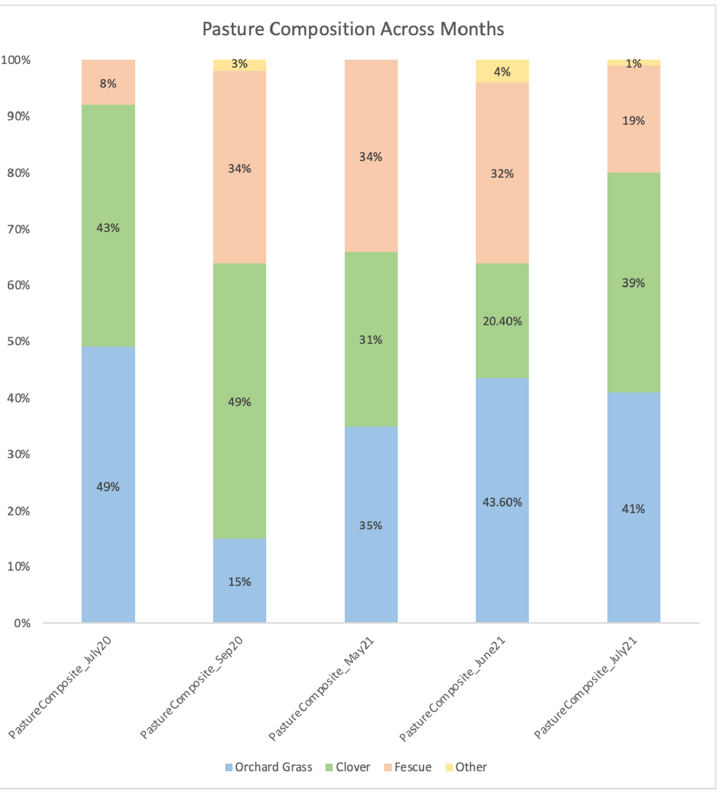
Figure 1. Pasture compositions across grazing months. The bars show the average percent of pasture species from 5 independent samples collected from the same paddock at a sampling period. Colors show the different pasture species.